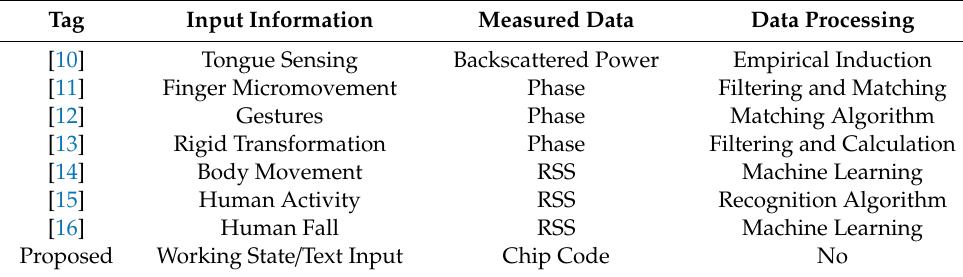
Table 1. Comparison between the tags in [10–16] and the proposed